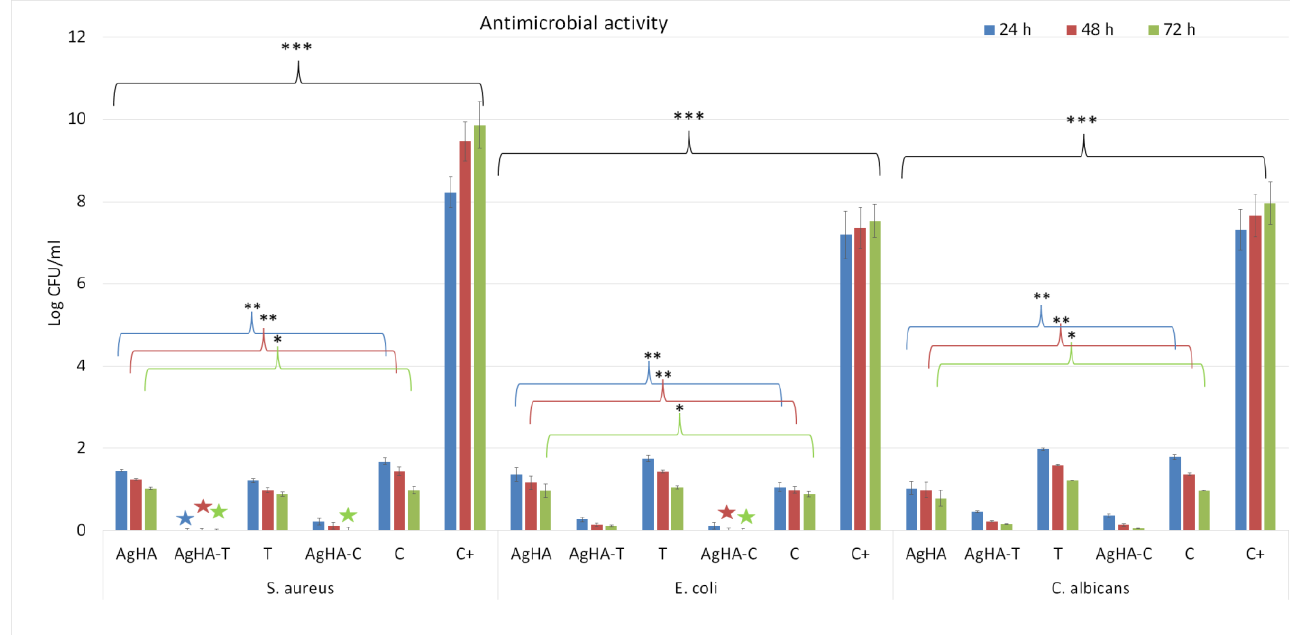
Figure 7. Graphical representation of the logarithmic values of colony forming units (CFU)/mL of S. aureus ATCC 25923, E. coli ATCC 25922, and C. albicans ATCC 10231 microbial strains after 24, 48 and 72 h of incubation with AgHA, AgHA-T and AgHA-C suspensions. The results are depicted as mean ± standard deviation from 3 independent experiments. The statistical analysis was performed using one-way ANOVA. The p -values indicated correspondence are * p ≤ 0.003, ** p ≤ 0.001, *** p ≤ 0.0001. The stars depict the bactericidal activity of the samples.